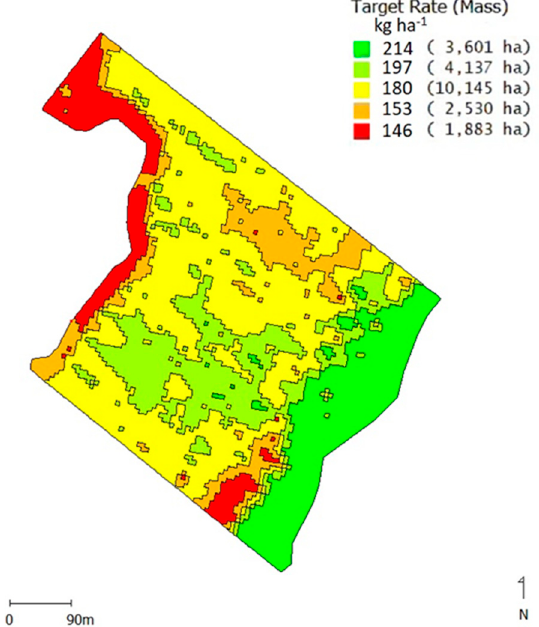
Figure 8. Winter wheat VRS map. The colored parameter variation was created by the authors using SMS software with the data received from an ECa map.